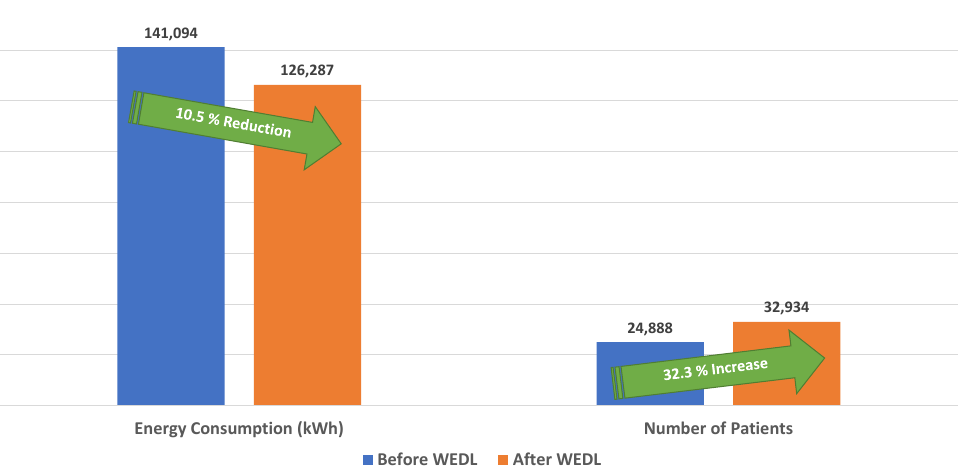
Figure 11. Energy consumption status in the NHS hospital, before and after the introduction of the wireless electricity data